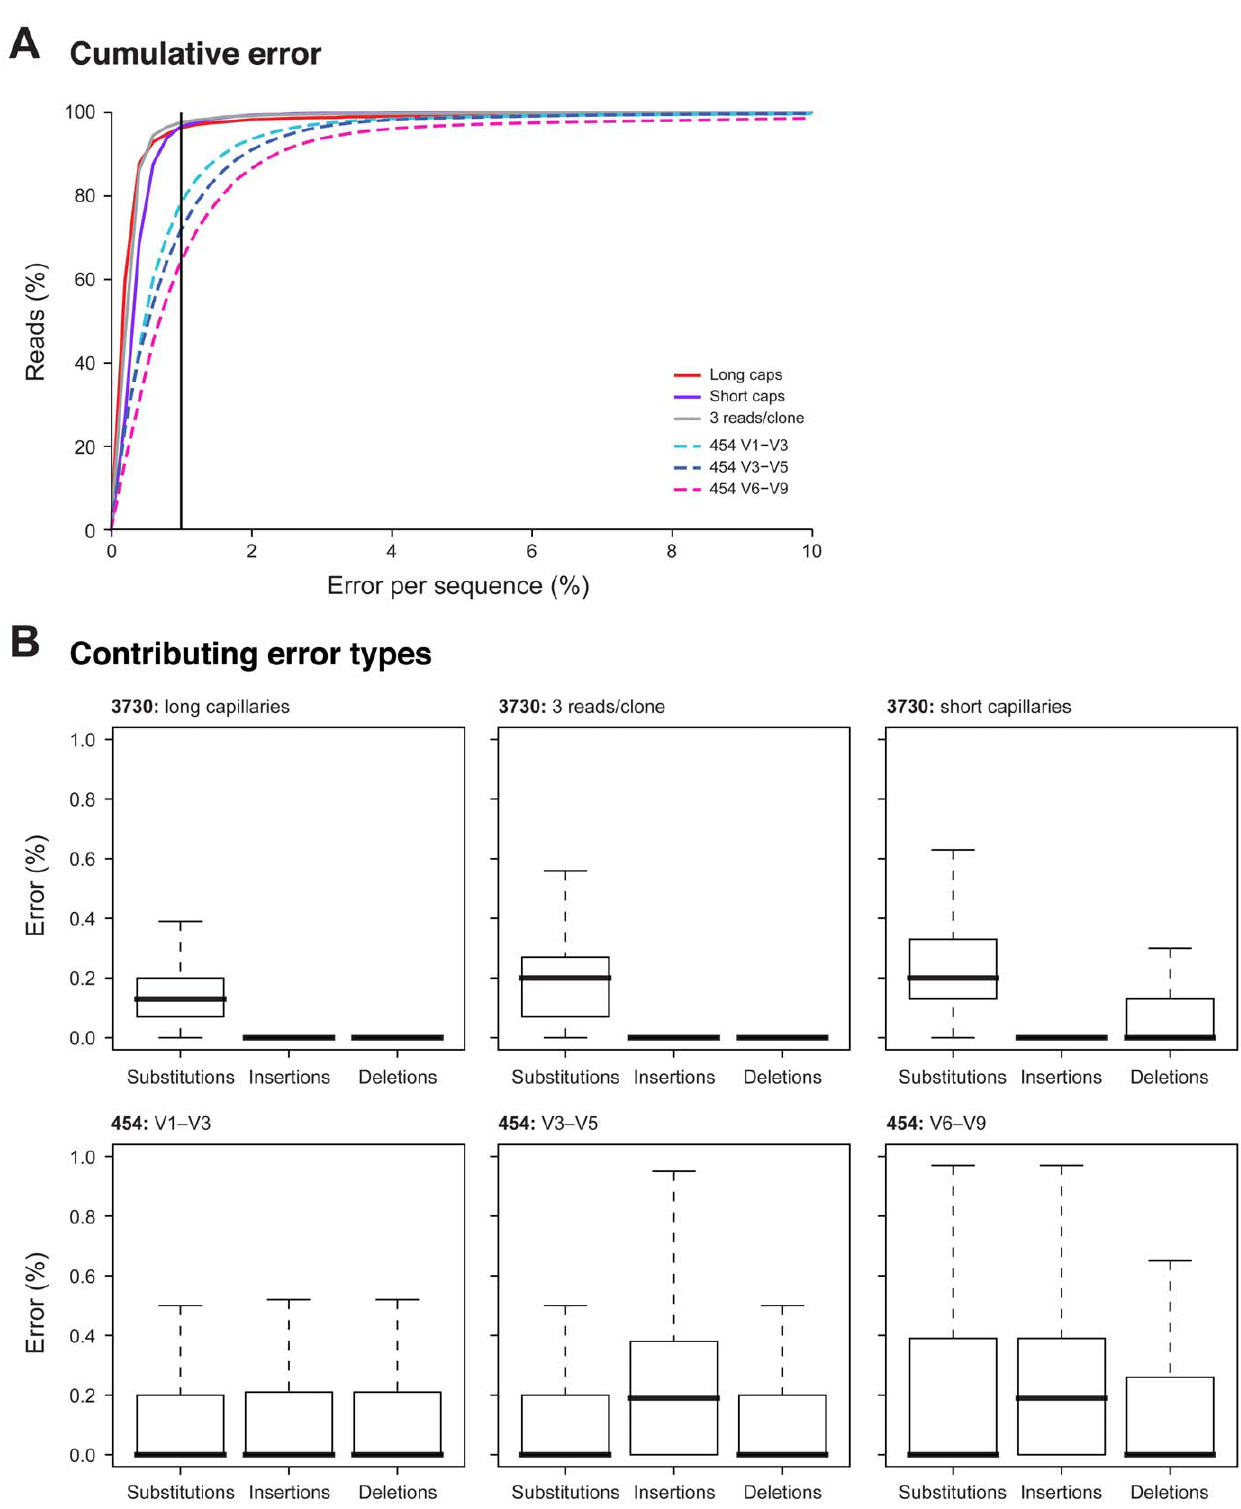
Figure 6. 454 sequences have a higher error rate, mainly resulting from an increased insertion and deletion rate. (A) For all the quality and chimera filtered 3730 and 454 sequences generated for the MC sample, an alignment-based estimation of errors, including insertions, deletions, and substitutions was performed. For each of the different sequencing approaches, the cumulative frequency distribution of the percent error per sequence is shown for assembled 3730 sequences generated with short capillaries (green), long capillaries (red), and three reads per clone (yellow), and 454 reads spanning the variable regions V1–V3 (light blue), V3–V5 (dark blue), and V6–V9 (fuchsia). A vertical line at 1% was added as a visual aid for upper limit of an acceptable error threshold. (B) Boxplots show the average percentage of errors per read, per sequence approach and per error type, including substitutions, insertions, and deletions. Outliers are not shown. doi:10.1371/journal.pone.0039315.g006 PLoS ONE |